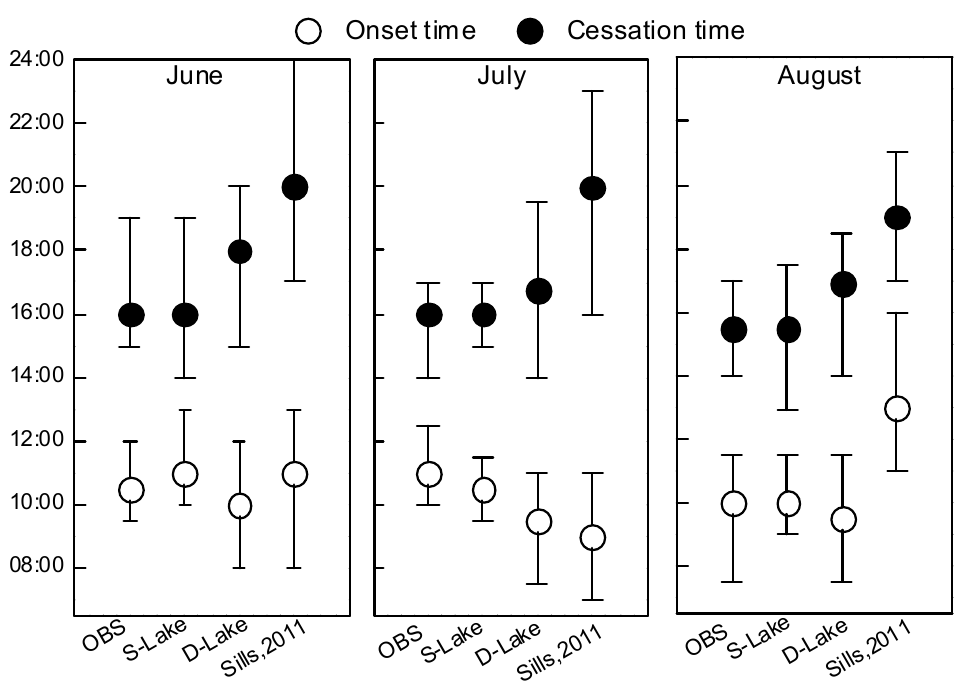
Figure 5. Modeled and observed mean and range of lake breeze onset time, cessation time and duration time for the three‑month study period.